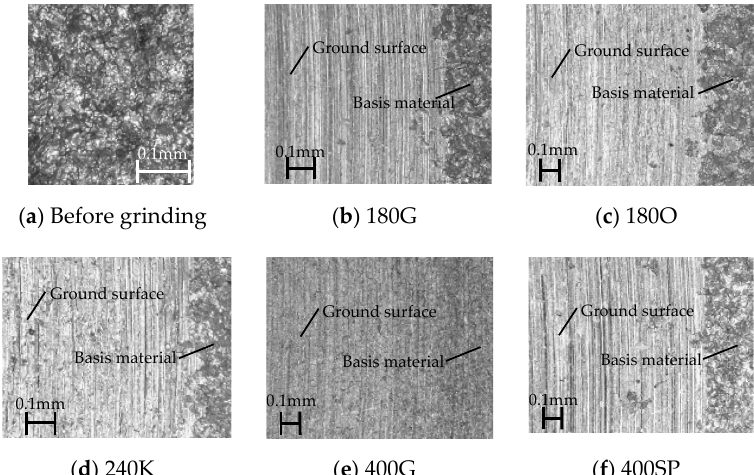
Figure 8. Surface properties of the stainless steel sheet ( a ) Before grinding ( b ) 180G ( c ) 180O ( d ) 240K